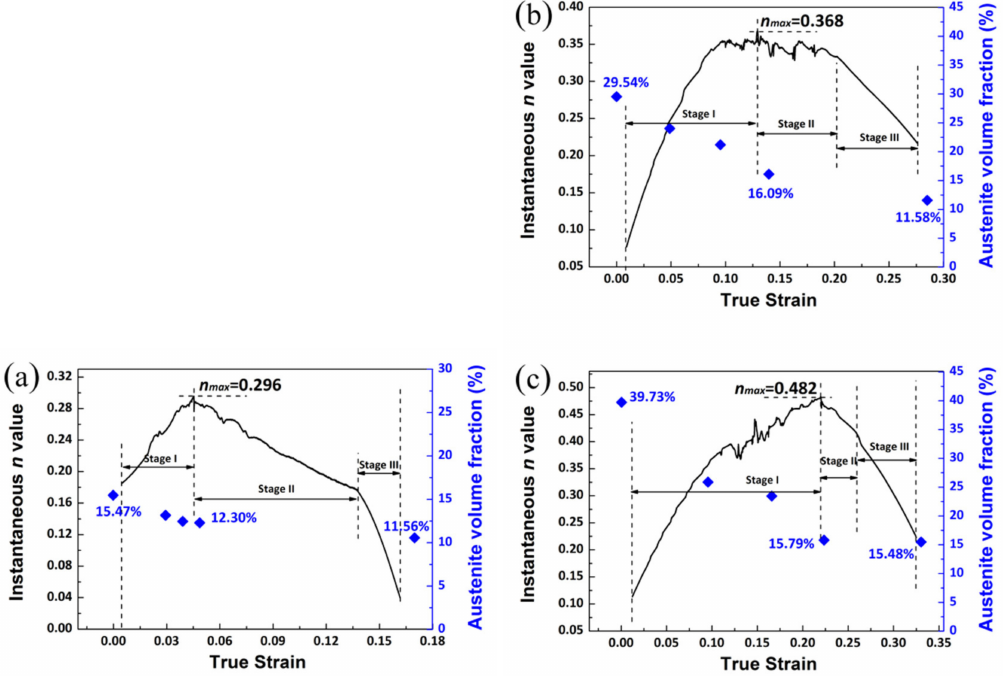
Figure 8. Work hardening behavior and austenite volume fraction evolution. ( a ) 0.06C steel, ( b ) 0.15C steel, and ( c ) 0.3C